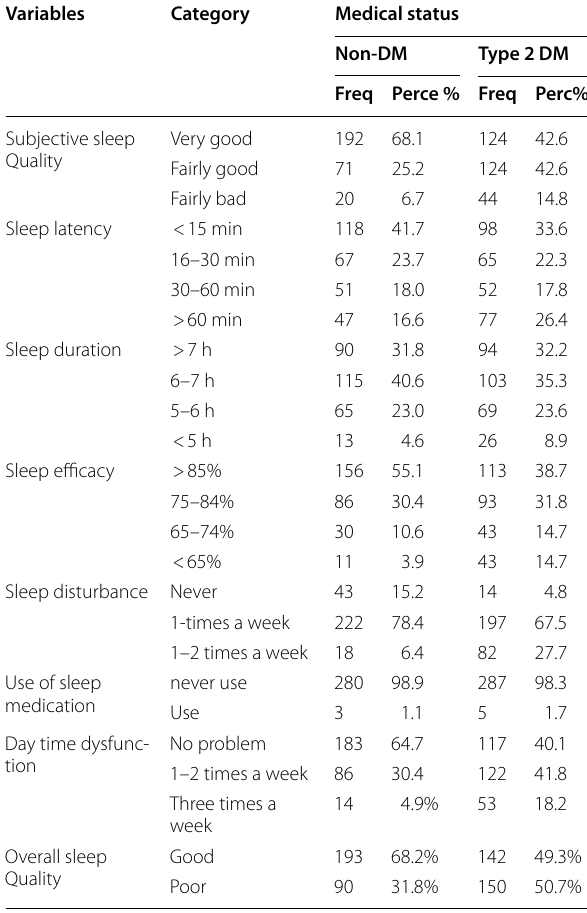
Table 5 Components of PSQI among individuals with type 2 DM and Non-DM individuals Bahir dar city, Ethiopia, 2021 (575)